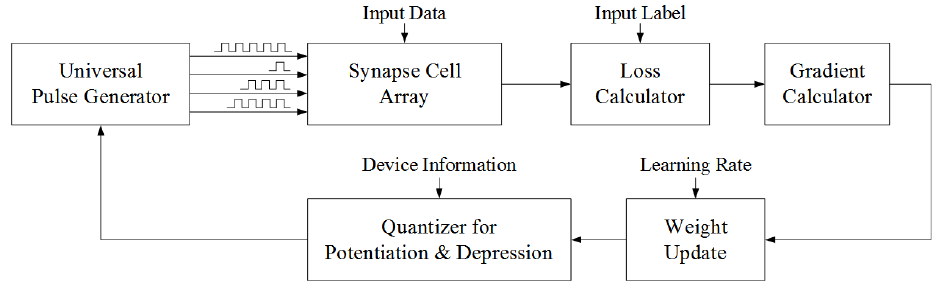
Figure 3. Proposed quantization